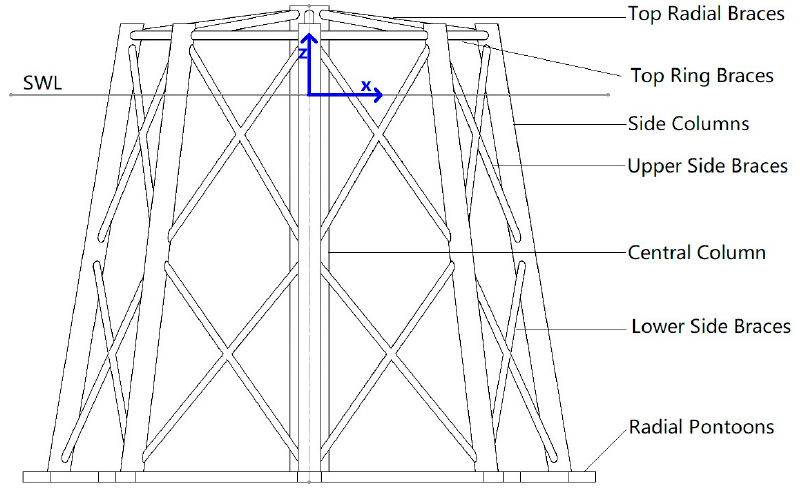
Figure 2. Side view of the fishing cage.